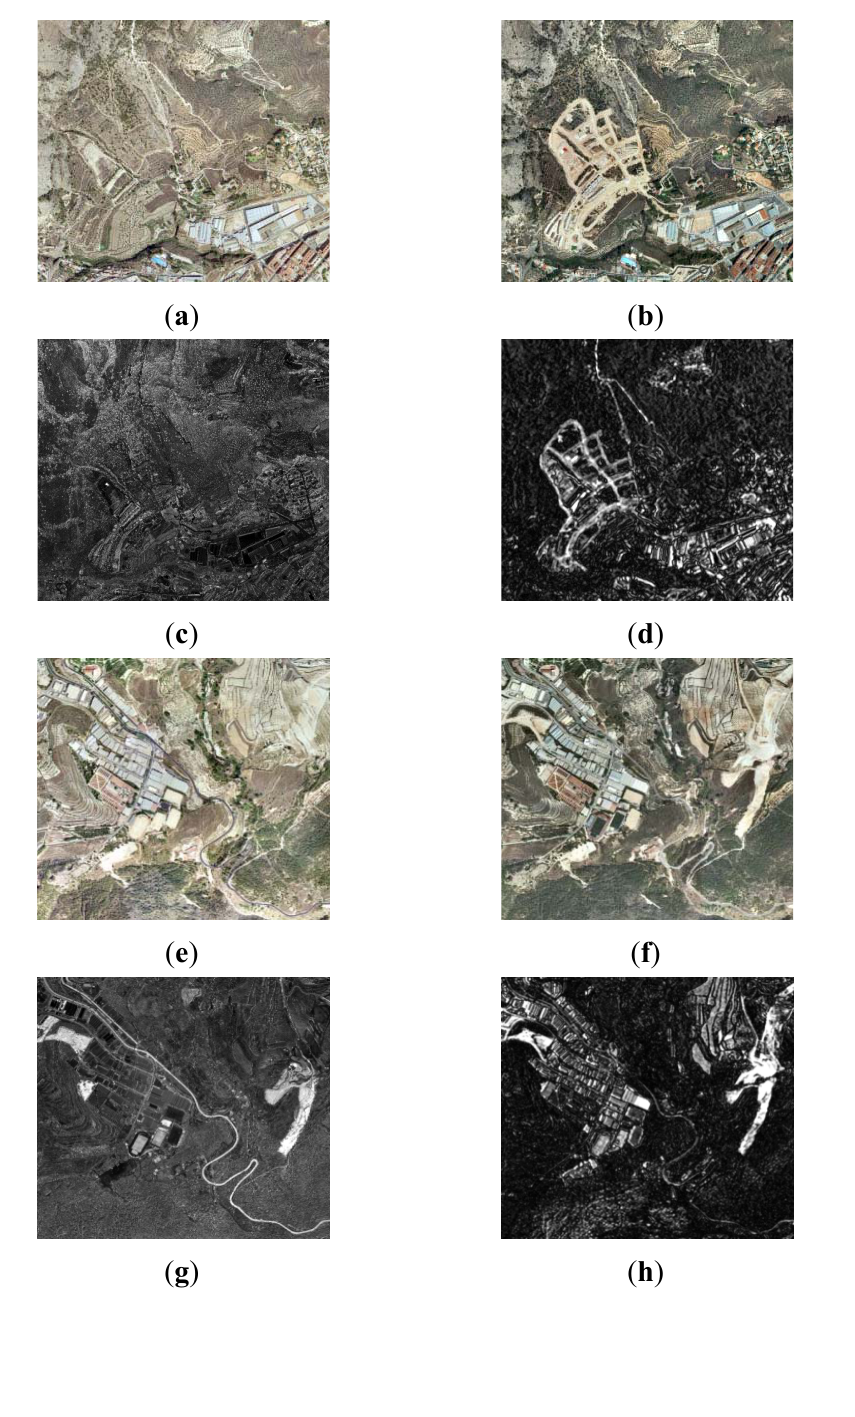
Figure 5. Level 3 processing, aerial images ( a ) area A1: 2005 Orthoimage; ( b ) area A1: 2007 Orthoimage; ( c ) area A1: CD CVA index; ( d ) area A1: CD Texture-Homogeneity CVA index; ( e ) area A2: 2005 Orthoimage 2005; ( f ) area A2: 2007 Orthoimage; ( g ) area A2: CD CVA index; ( h ) area A2: CD Texture-Homogeneity CVA